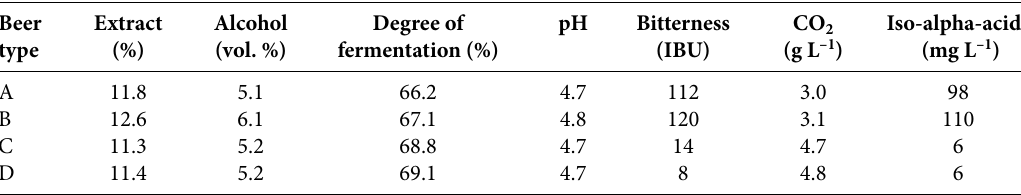
Table 2. Basic beer characteristics for each beer